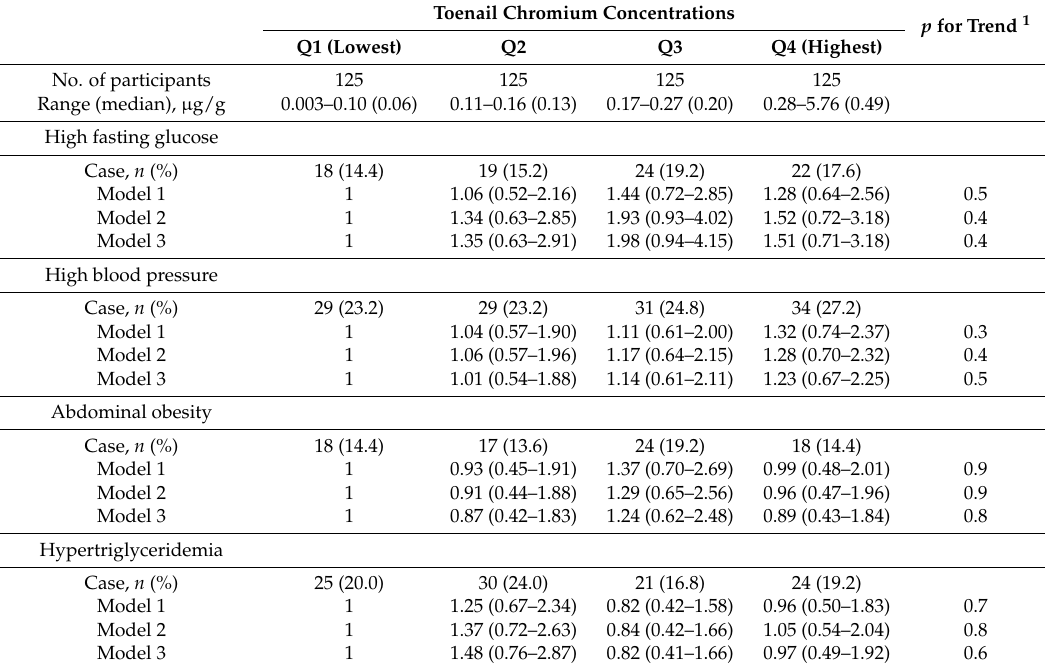
Table 3. Odds ratio and 95% confidence interval for metabolic syndrome and its components in participants according to quartiles of toenail chromium concentrations, the SELEN study ( n = 500). Toenail Chromium